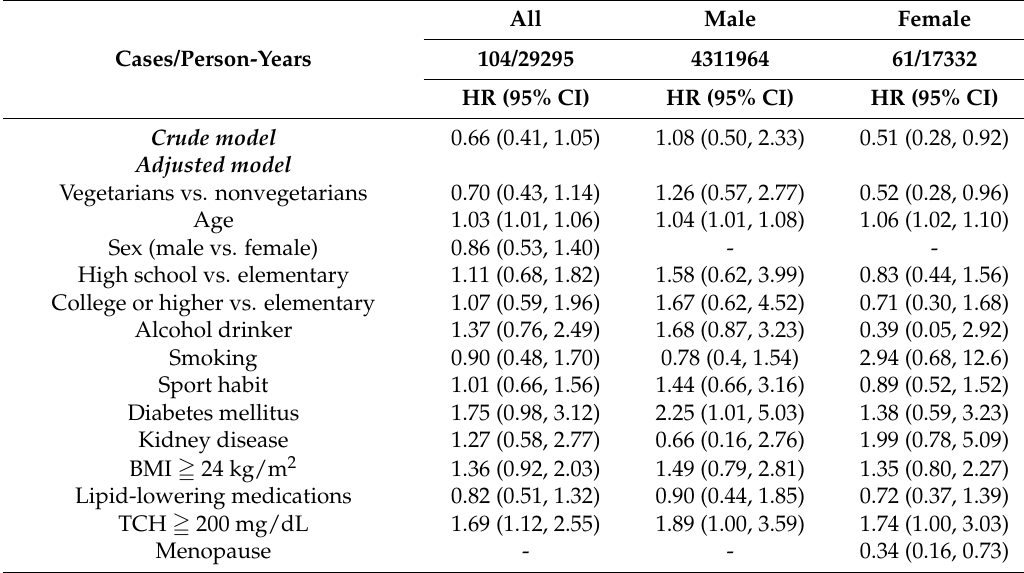
Table 3. Cox proportional hazards regression for risk of gallstone disease.